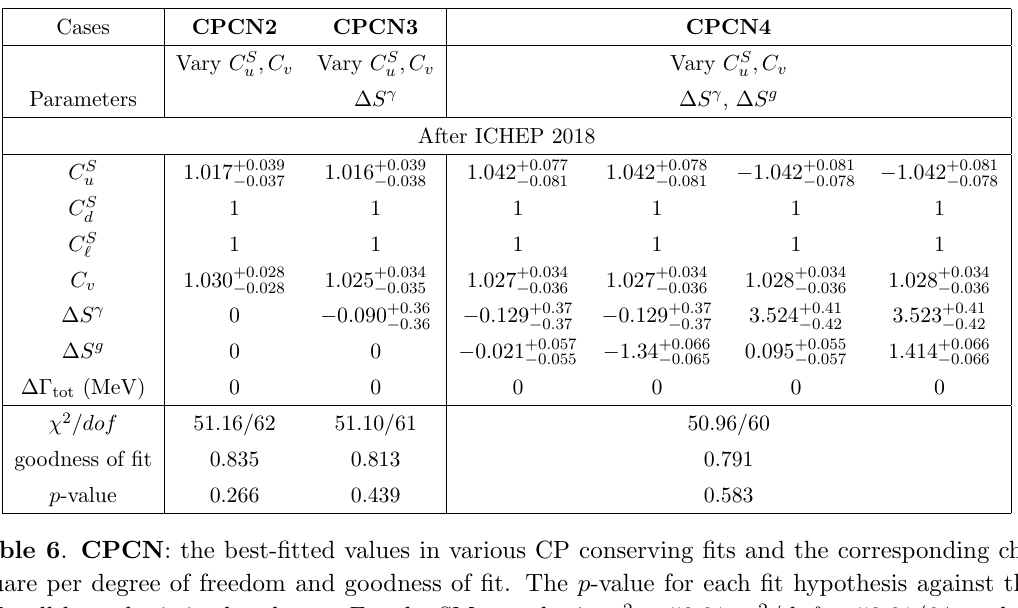
and C v . The color code u